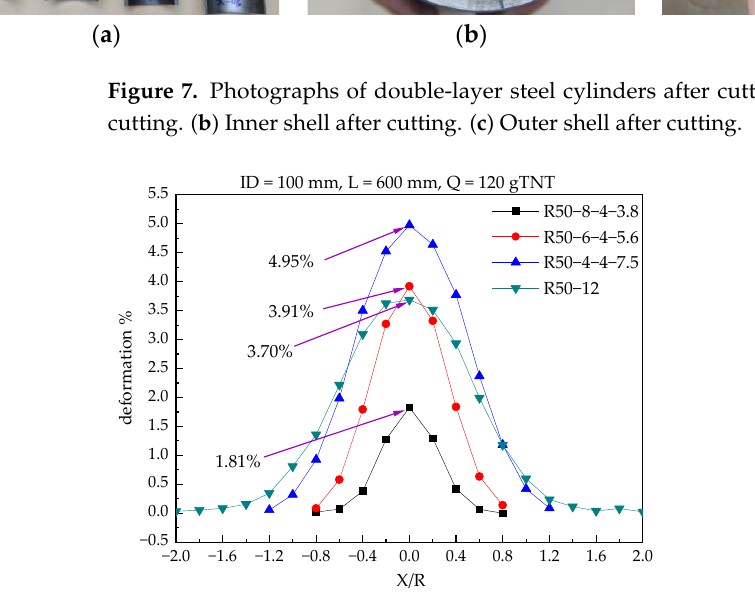
Figure 8. Comparison of the deformation of a single shell to double-layer shells.